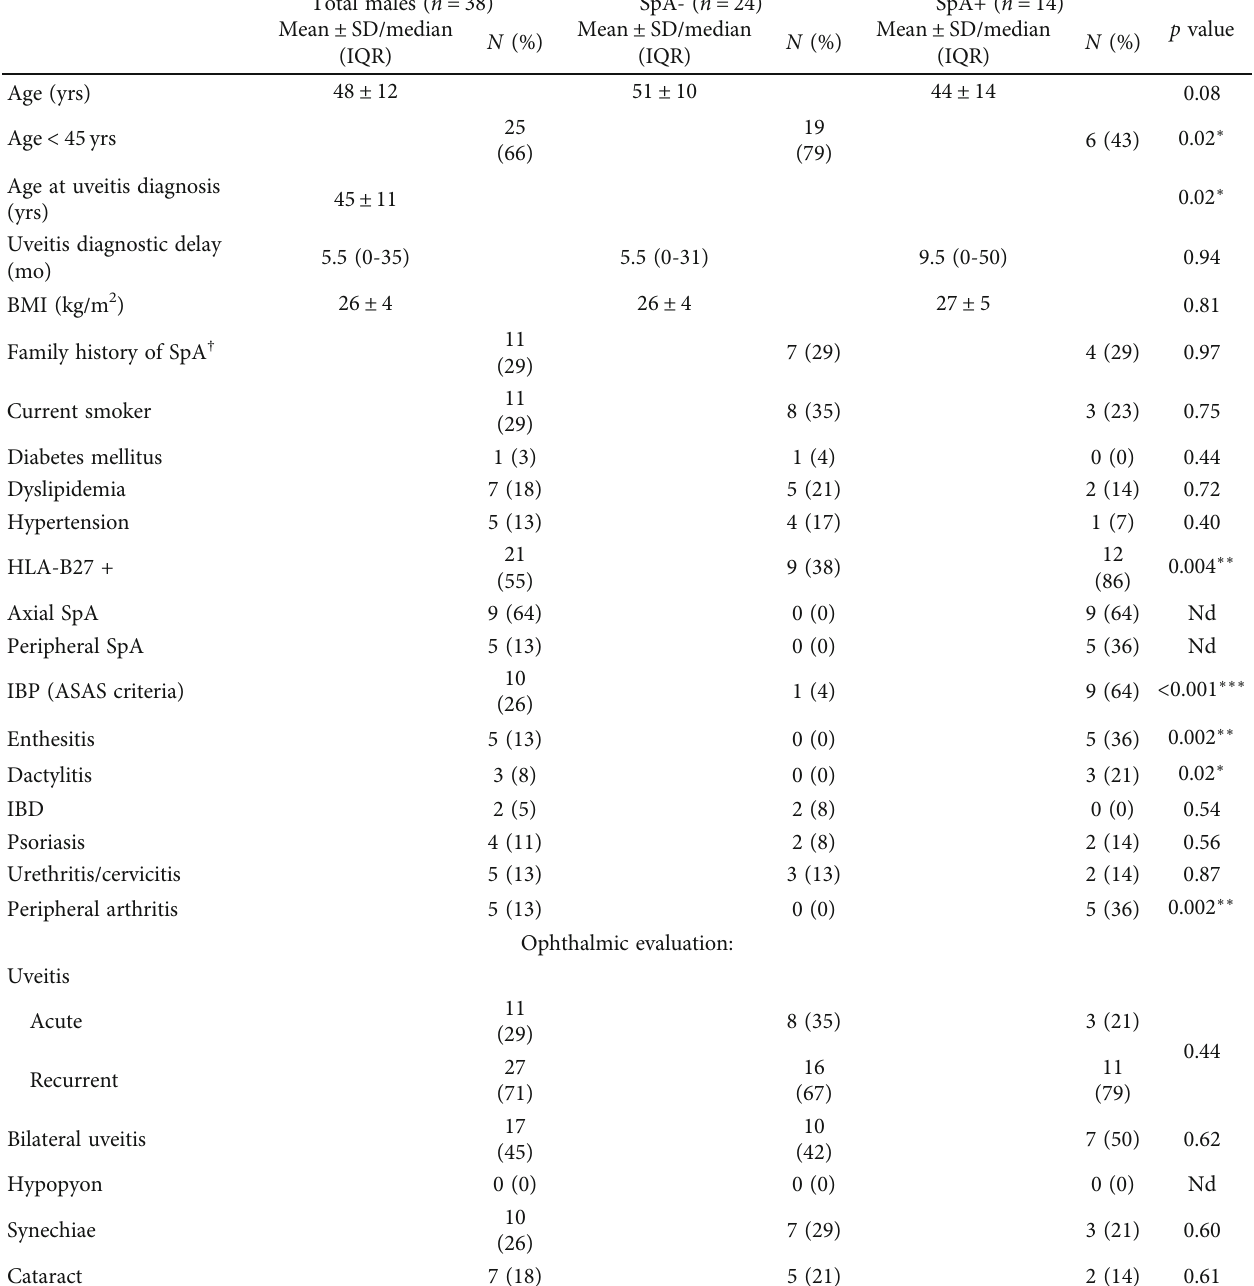
Table 2: Main characteristics of study population according to male